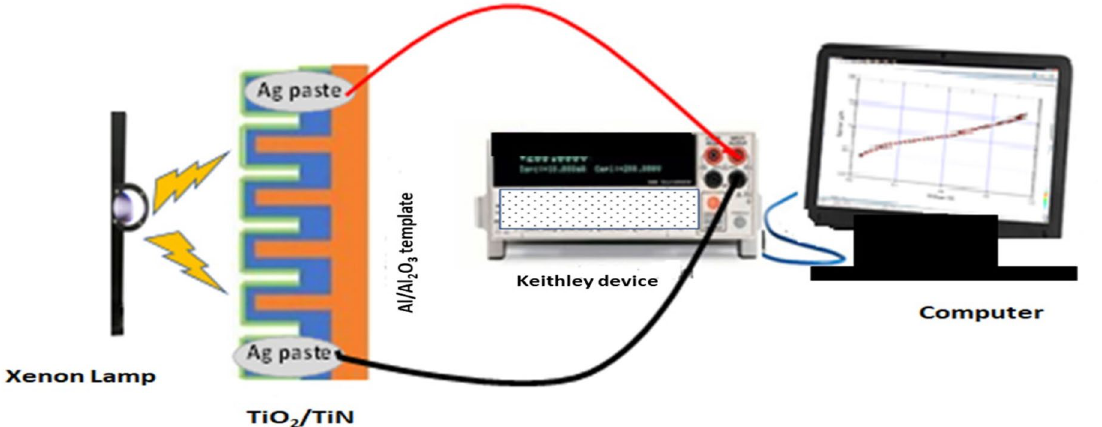
Figure 1. Scheme for testing the prepared materials as a photodetector.